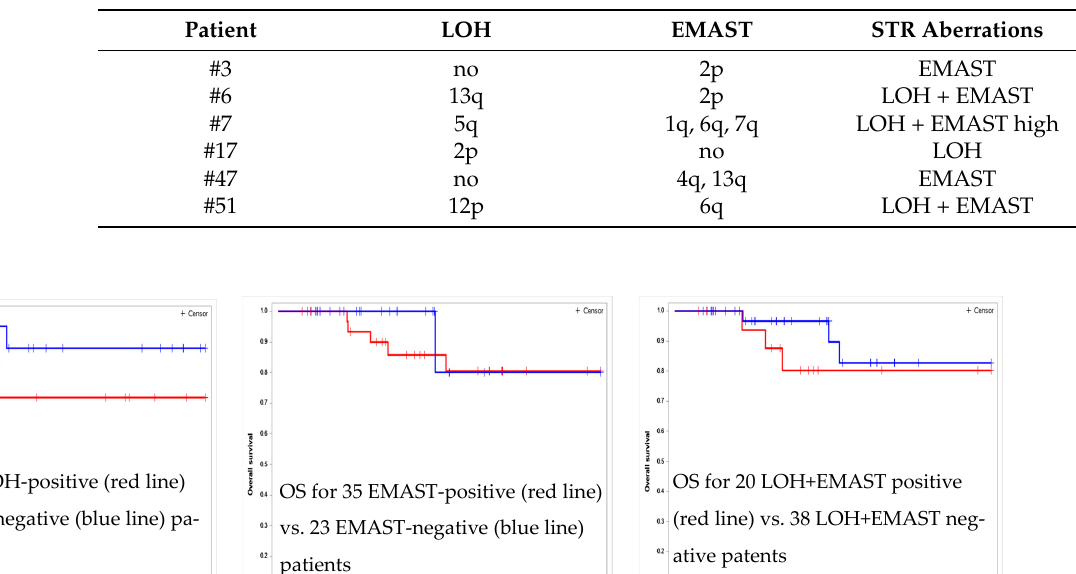
Table 2. LOH and EMAST patterns in the patients undergoing R-Da-EPOCH-21, who died from disease progression (6 from 58 patients, 10.3%).